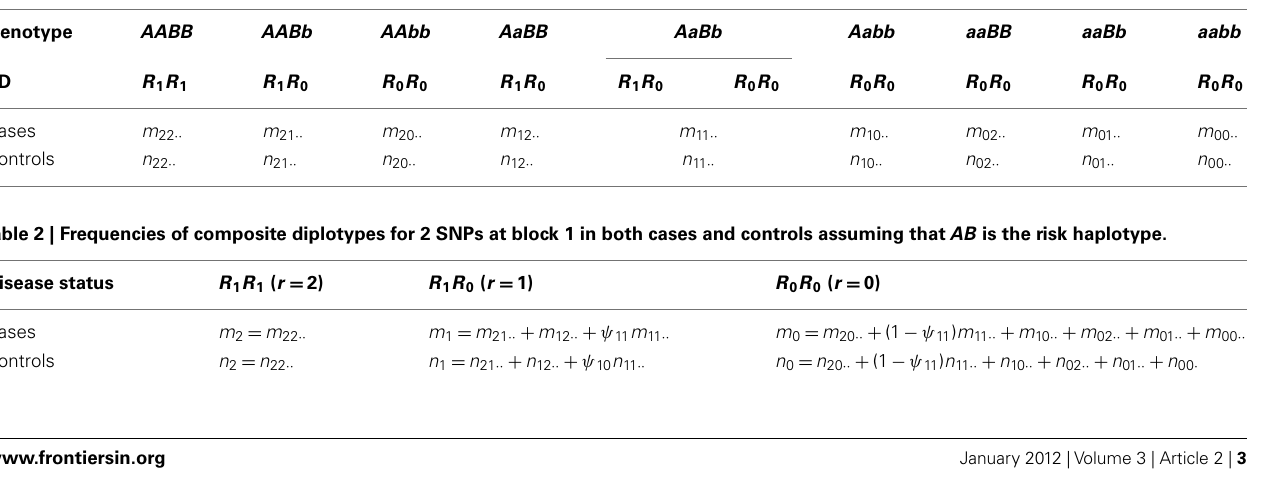
Table 1 | Frequencies of 2-SNP genotypes at block 1 calculated from genotypic observations for 2 SNPs at block 1 in both cases and controls. The composite diplotypes (CD) of each genotype are also given assuming that AB is the risk haplotype.